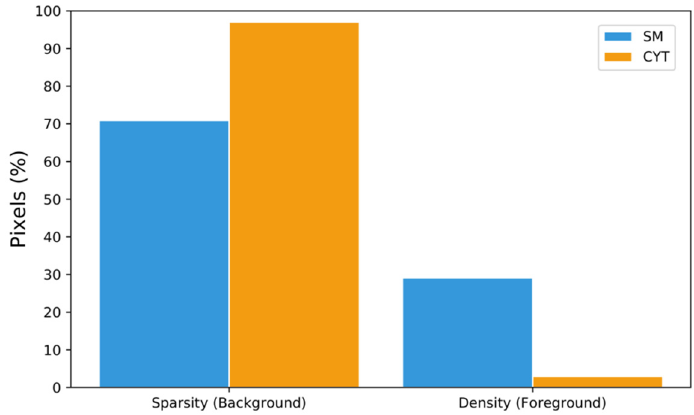
Figure 12. Comparison between average density and average sparsity for SM and CYT distributions.